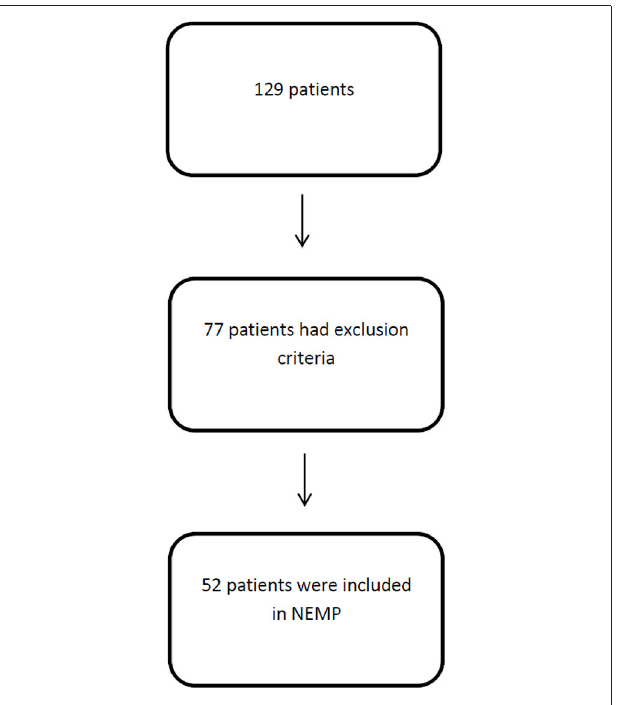
FIGURE 4 | Flowchart with patients excluded and included in NEMP.